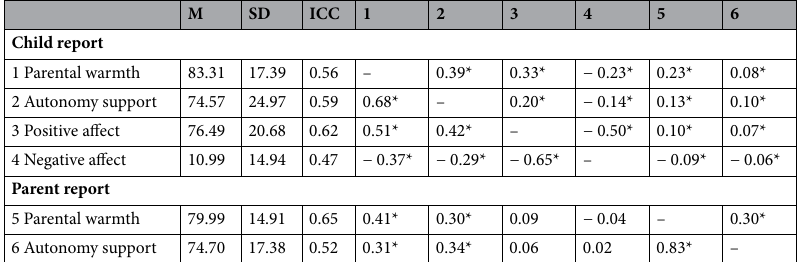
Table 1. Descriptive statistics and correlations for study variables. ICC, intraclass correlation coefficient. All items ranged from 0 to 100. Between-family correlations are presented under the diagonal (and represent associations between average levels), within-family correlations are presented above the diagonal (and represent how day-to-day fluctuations are associated) * p < 0.001.